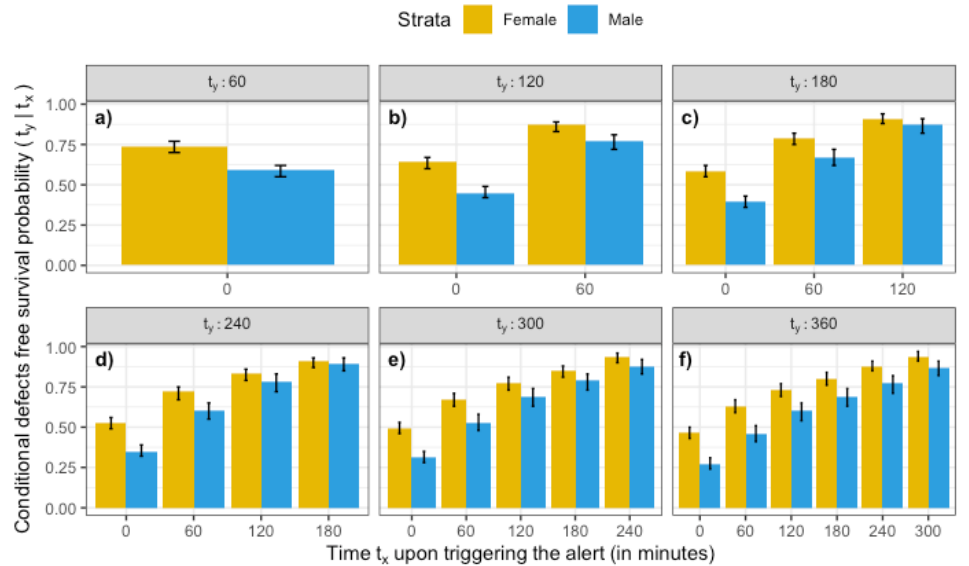
used for analysing the effect size that the (cid:12) (cid:1) (cid:0) t y . Note: (cid:12) t x . Note: ( 𝑑𝑑 𝐷𝐷𝐹𝐹 ) 𝐶𝐶𝐷𝐷𝐷𝐷𝐷𝐷 �𝑡𝑡 𝑦𝑦 �𝑡𝑡 𝑥𝑥 �